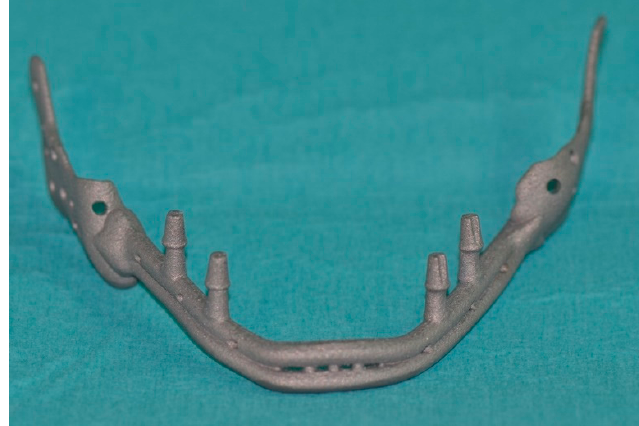
Figure 9. The mandibular prosthesis produced by direct metal laser forming (DLMF) technology.